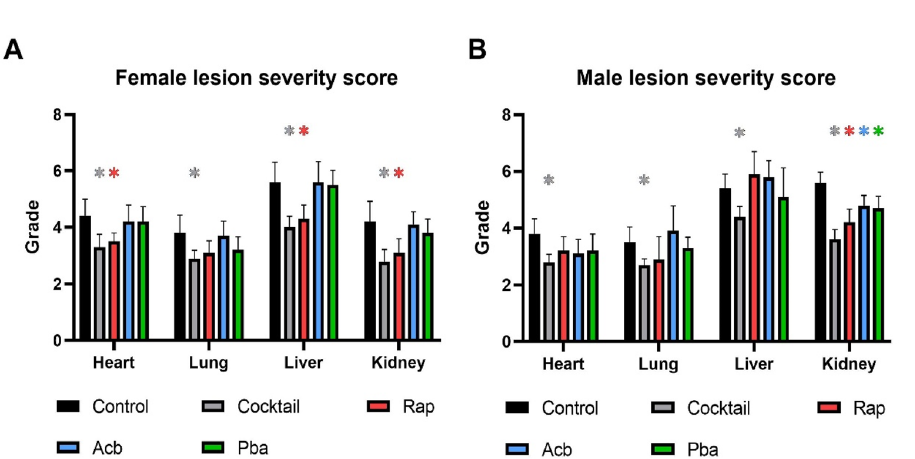
Figure 3. Lesion severity scores were calculated in four major organs from C57BL/6 mice fed chow with a three-drug cocktail or each individual drug for 3 months starting at 20 months of age. (A) Female lesion severity scores. (B) Male lesion severity scores. N = 12–14/cohort. *P < 0.05; 2-way ANOVA with Pearson chi-square test.